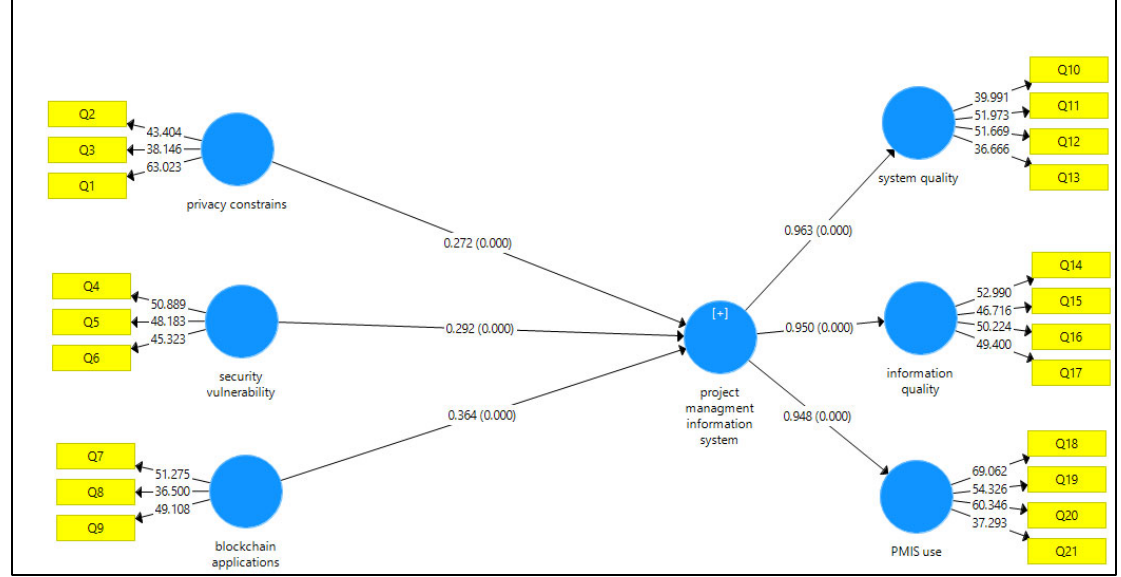
Fig. 2. Structural Research